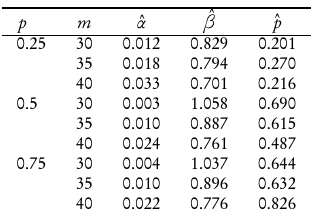
Maximum likelihood estimates of α , β and p based on cancer patient data for different choices of p = 0.25,0.5 and 0.75 .